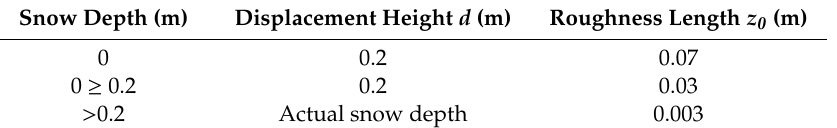
Table 1. Values of displacement height d and roughness length z 0 used throughout the measurement period (2010–2013), depending on snow cover thickness. The values for snow-free conditions were determined experimentally in situ, while roughness lengths for different snow conditions were estimated based on available literature and site characteristics.